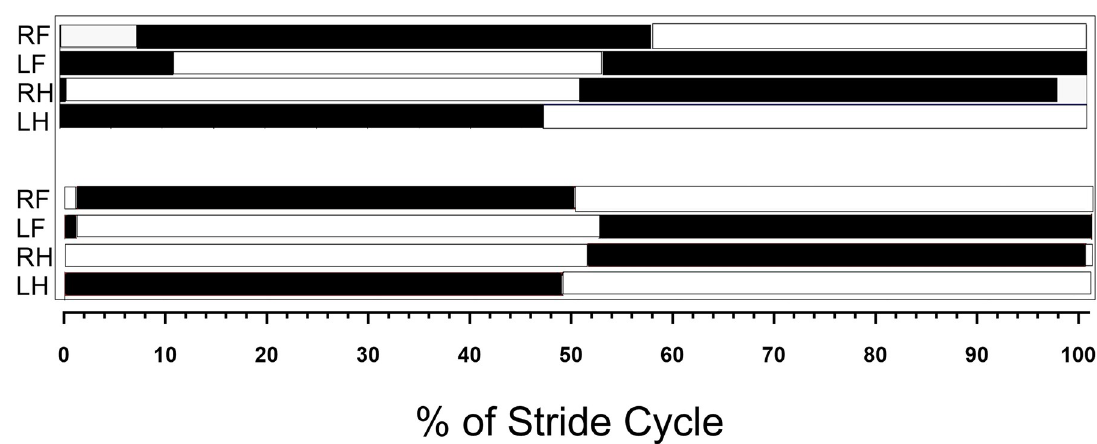
Fig 3. Two-footfall sequence represented in bar diagrams of 0 to 100% marcha batida gait stride cycle (black bars represent moments of support and white bars represent moments of suspension).